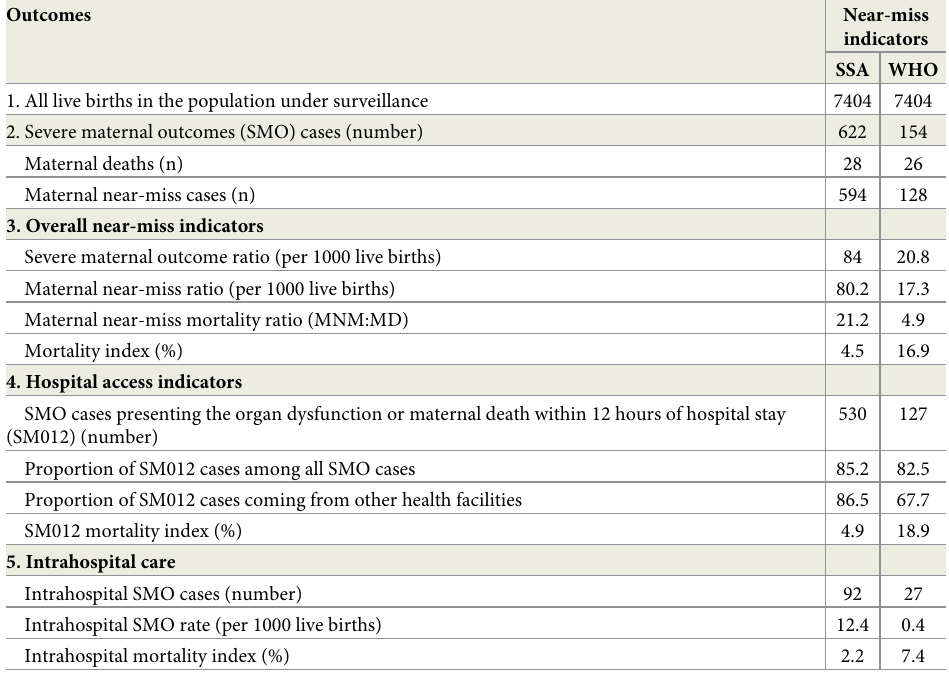
Table 4. Severe maternal outcomes and near-miss indicators in eastern Ethiopia,